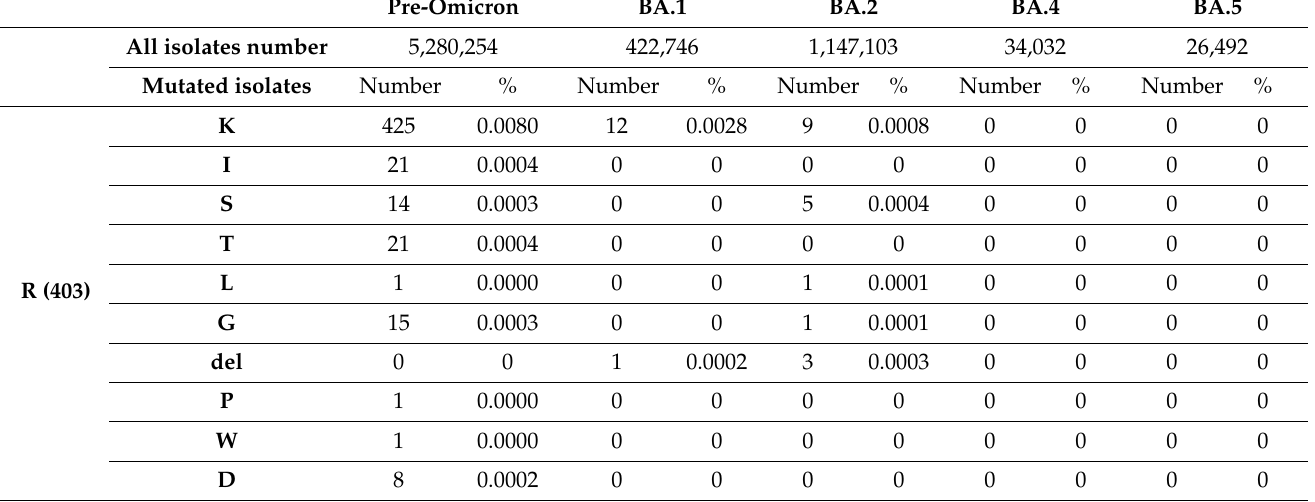
Table 1. Analysis of the total number and percentage of isolates carrying different mutations in the Spike RGD motif from Pre-Omicron and Omicron BA.1, BA.2, BA.4, and BA.5 lineages. Pre-Omicron